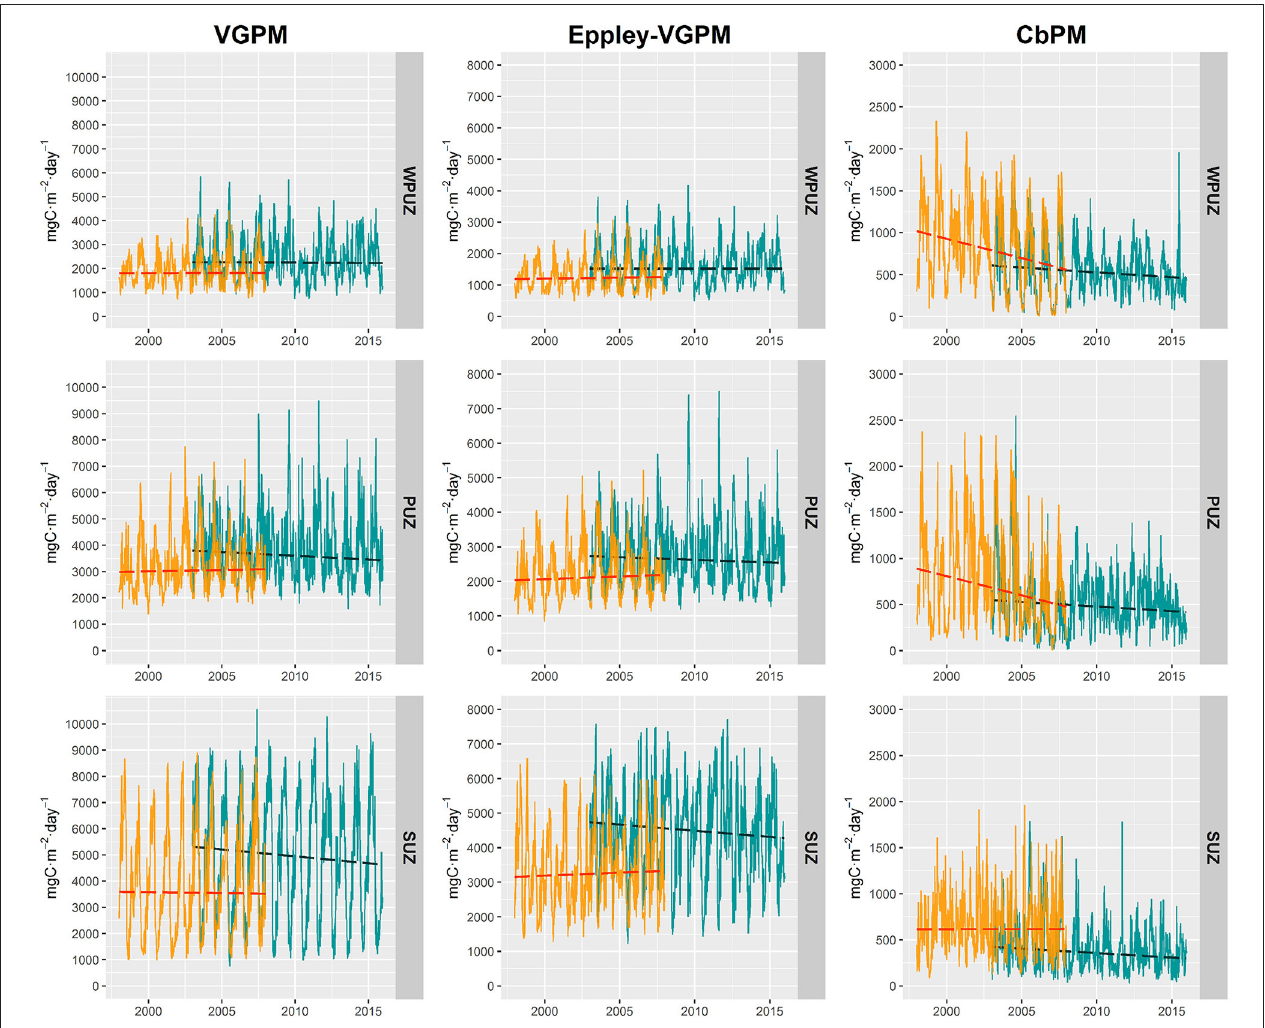
FIGURE 6 | Average time series in the shelf portion of each upwelling zone and their corresponding trend (dashed, Table 1 ) for VGPM, Eppley-VGPM, CbPM. Orange corresponds to SeaWiFS-based data and blue to MODIS-based